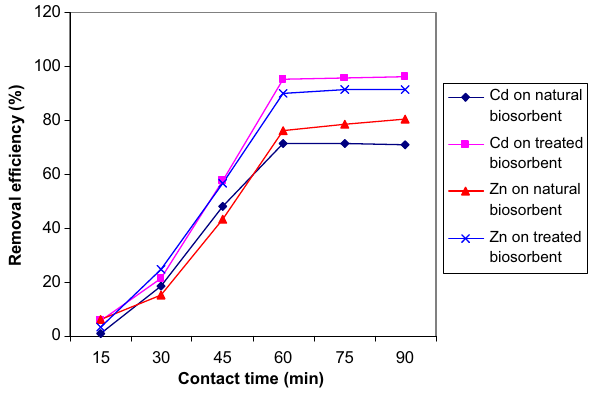
Fig. 5 Effect of pH on Cd and Zn biosorption